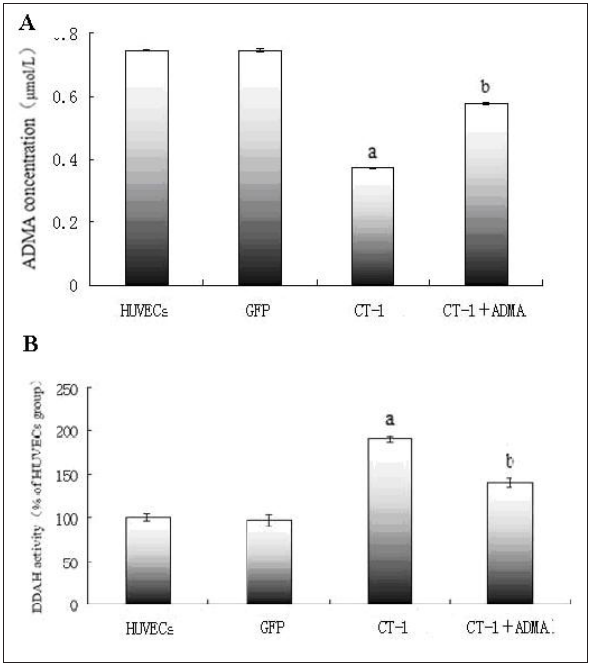
Fig. 8. ADMA level and DDAH activity at 48 h after transfec- tion. (A) The AMDA level at 48 h after transfection. (B) The activity of DDAH at 48 h after transfection. a P <0.05 vs HUVEC sgroup, b P <<0.05 vs CT-1 group.